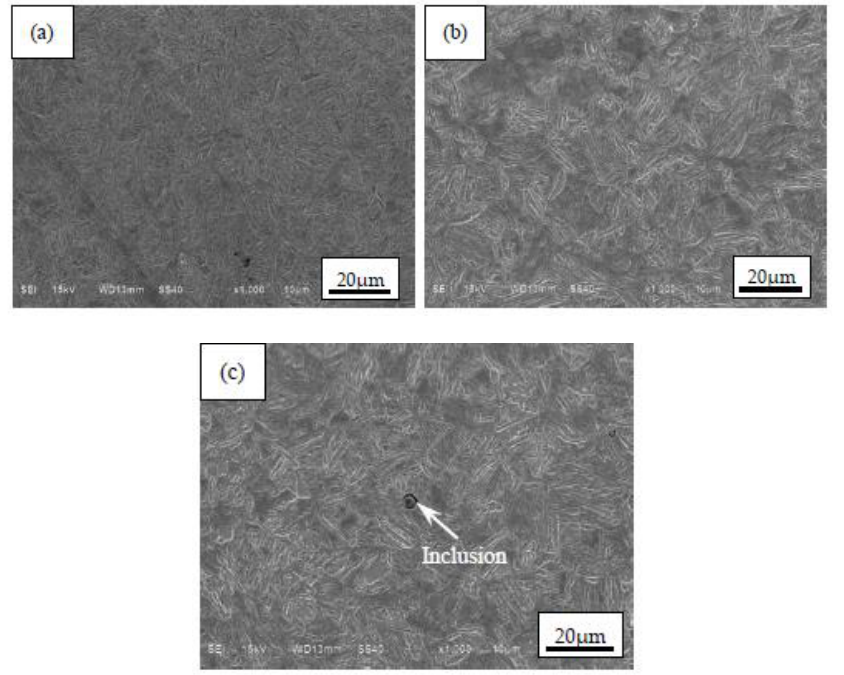
Figure 2. Microstructure observation of carburized 12Cr2Ni alloy steel: ( a ) microstructure in carburized layer; ( b ) microstructure in core region; ( c ) inclusion.